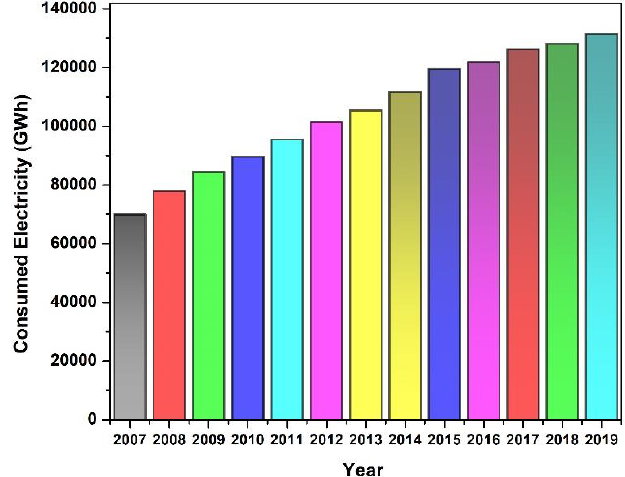
Figure 7. Consumed electricity (GWh) per year in the UAE [62].